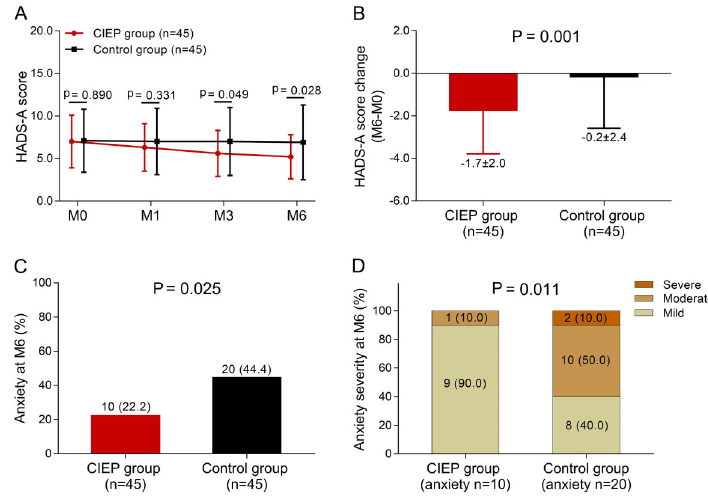
Figure 2. Effect of caregiver intensive education program (CIEP) on anxiety in patients with drug-resistant temporal lobe epilepsy and mesial temporal sclerosis (TLE-MTS) who underwent cortico-amygdalohippocampectomy (CAH). A , HADS-A score at month (M)0, M1, M3, and M6 in the CIEP group and control group; B , HADS-A score change (M6-M0) in the two groups. Data are reported as means ± SD. C , Percentage of patients with anxiety in the two groups and D , percentage of anxiety severity in the two groups. P o 0.05 was considered statistically signi fi cant by Student ’ s t -test, Wilcoxon rank sum test, or chi-squared test. HADS-A: Hospital Anxiety and Depression